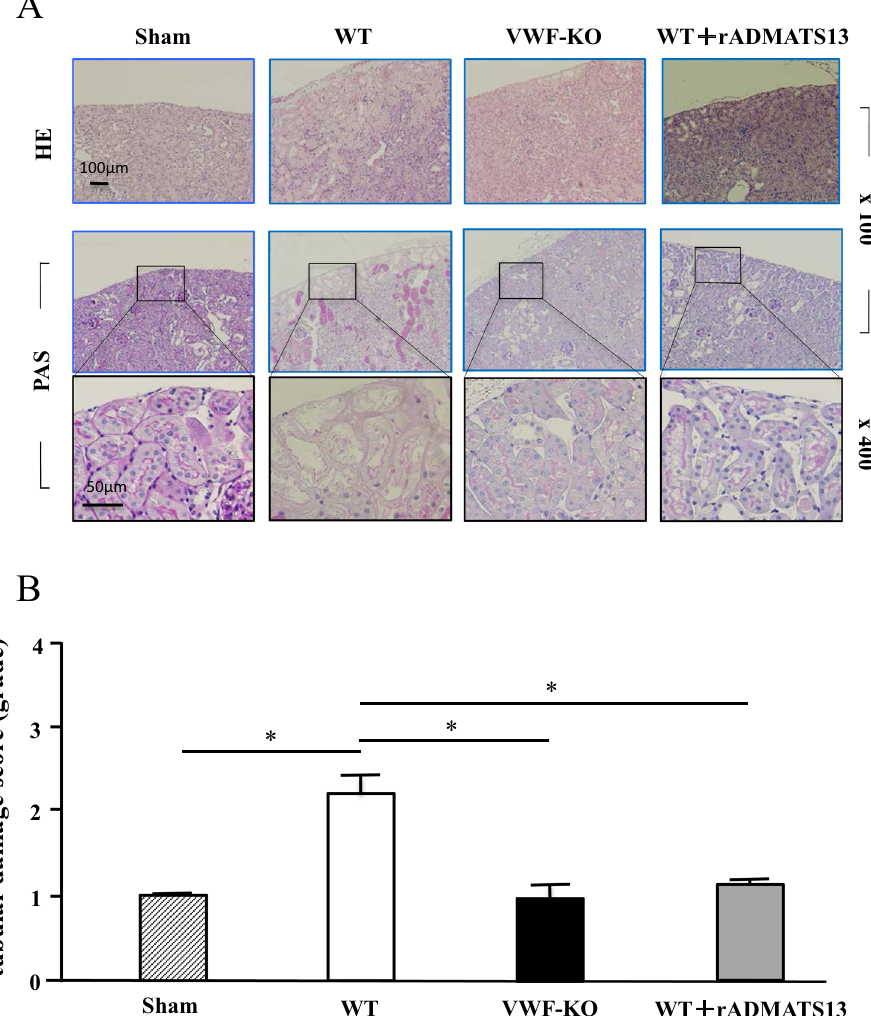
Figure 2. Histological analysis with HE and PAS staining of kidney tissue in WT mice with or without rADAMTS13 infusion and in VWF-KO mice. At 24 h after reperfusion (see the I/R protocol in Fig. 1), mice were sacrificed for histological analysis of kidney tissue. ( A ) Images of kidney tissue with HE staining (upper panels, original magnification, 100 × ) or PAS staining (middle panels, original magnification, 100 × ; and lower panels, enlarged images of areas enclosed in rectangles in corresponding middle panels, original magnification, 400 × ) are each representative of samples from 5 different mice. Note that tubular necrosis, as demonstrated by the loss of normal tubular construction (HE) or elimination of brush borders (PAS), is less severe in VWF-KO mice than WT mice, and rADAMTS13 injection ameliorated this tubular damage in WT mice. ( B ) Statistical analysis of the tubular damage scores corresponding to the above images; each bar represents the average ( ± SEM) of 15 areas (each 1 mm 2 ; 3 areas were randomly selected from 5 individual mouse samples). Note that tubular damage is significantly ( * ) less severe in VWF-KO mice than in WT mice. Note also that rADAMTS13 injection significantly ( * ) improves tubular damage in WT mouse Histological analysis of kidney tissue from WT mice with or without rADAMTS13 infusion and fromVWf-Ko mice after i/R kidney injury. WT mice, in which most proximal tubules were damaged, demonstrated marked renal tubular necrosis just inside the renal capsules, characterized by the loss of normal tubular construction (upper panels in Fig. 2A, HE samples) or by the elimination of brush borders (equivalent to PAS-negative tubules in the middle and lower panels of Fig. 2A, PAS samples). This tubular necrosis was less severe in VWF-KO mice, in which the tubular architecture was largely preserved (Fig. 2A). Consistent with the renal blood flow data (see Fig. 1), rADAMTS13 injection ameliorated the kidney damage in WT mice (Fig. 2A). Statistical analysis using the tubular damage score (Fig. 2B) confirmed that kidney injury was significantly less severe in VWF-KO mice (1.07 ± 0.18) than in WT mice (2.17 ± 0.25). In addition, the score for WT mice in which rADAMTS13 was injected (1.15 ± 0.08) indicated significantly less tubular damage compared with WT mice that did not receive an rADAMTS13 injection (Fig. 2B).